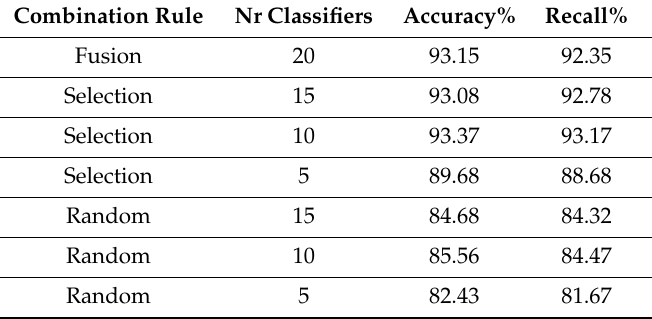
Table 8. The performance of fusion for all and selection of 15, 10, and 5